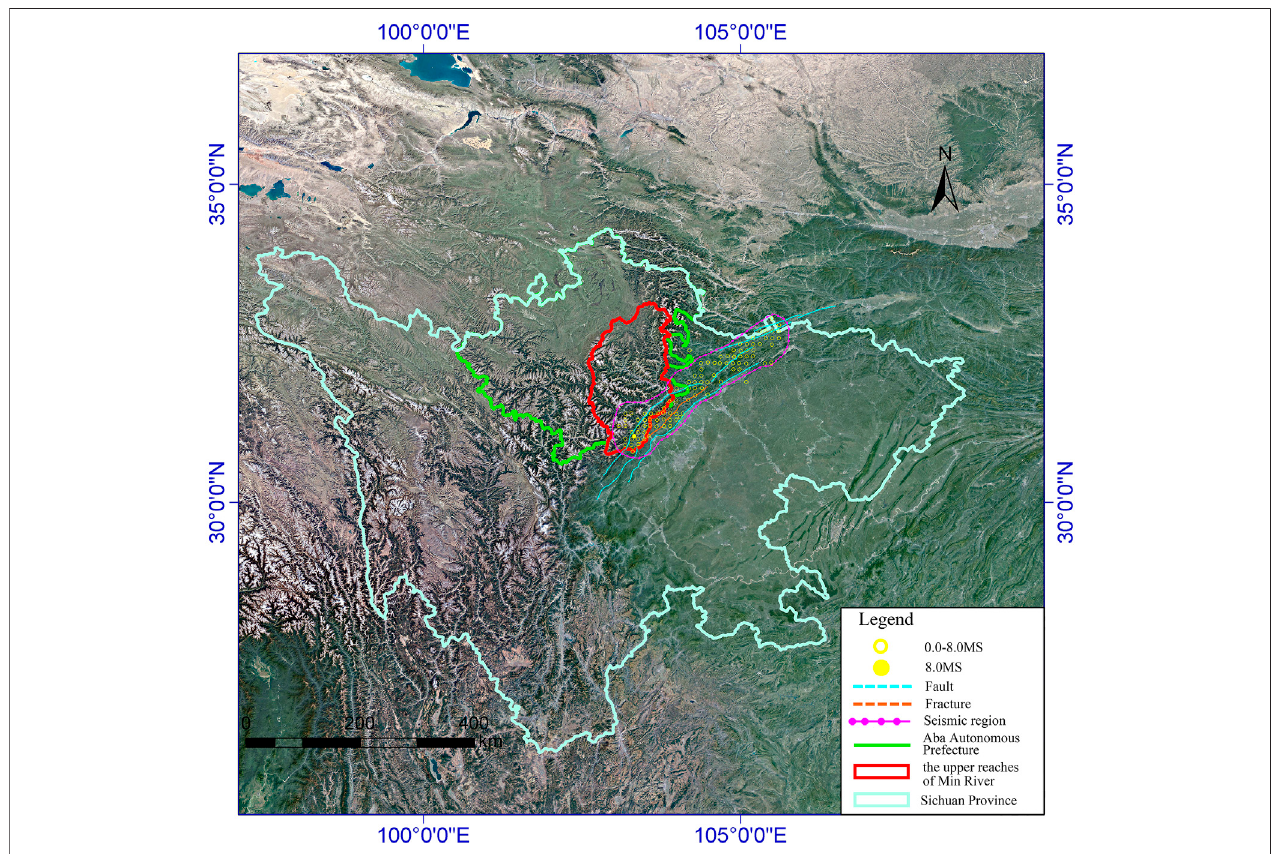
FIGURE 1 | Location of the upper reaches of Min River (according to Cui,